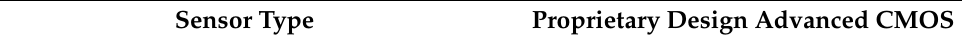
Table 4. Parameters of the camera.